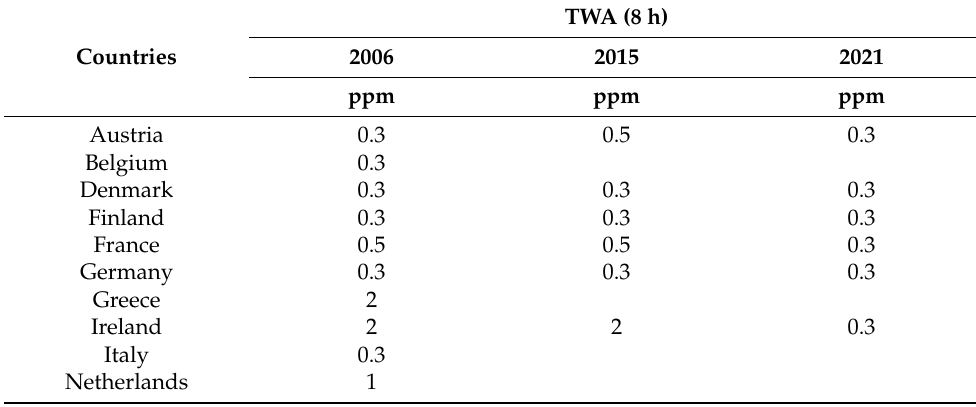
Table 1. Occupational Exposure Limits (OELs) for formaldehyde in European countries ([17,46–48]). TWA (8 h) 2006 2015 2021 Countries ppm ppm ppm Austria 0.3 0.5 0.3 Belgium 0.3 Denmark 0.3 0.3 0.3 0.3 0.3